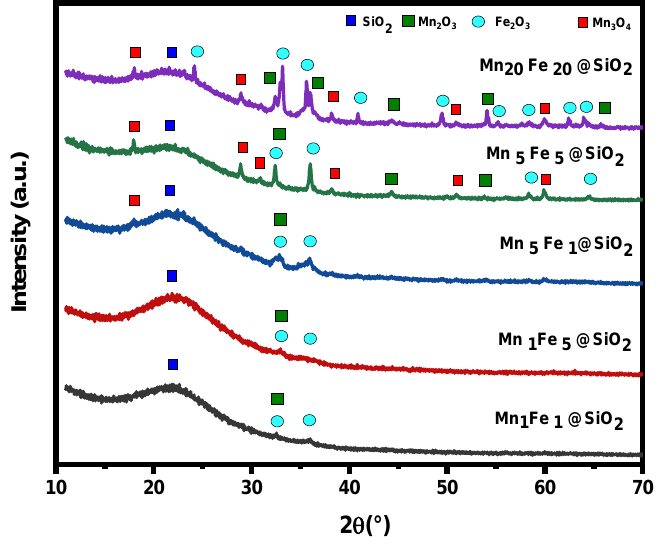
Figure 1. XRD patterns of M x F y @SiO 2 nanocomposites.